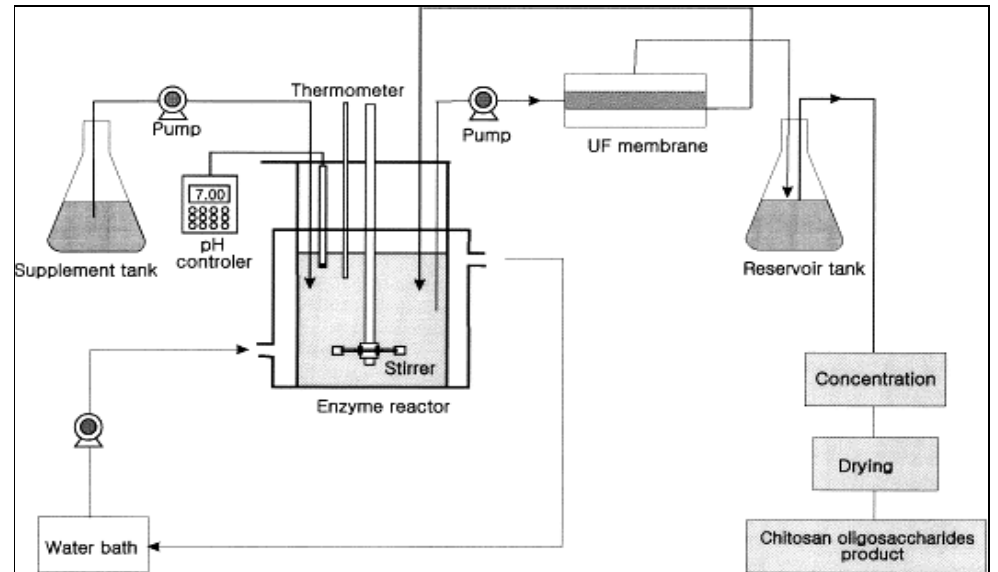
Figure 1. Schematic diagram for the production of chitooligosaccharides in the UF membrane reactor system (Adapted from Jeon and Kim